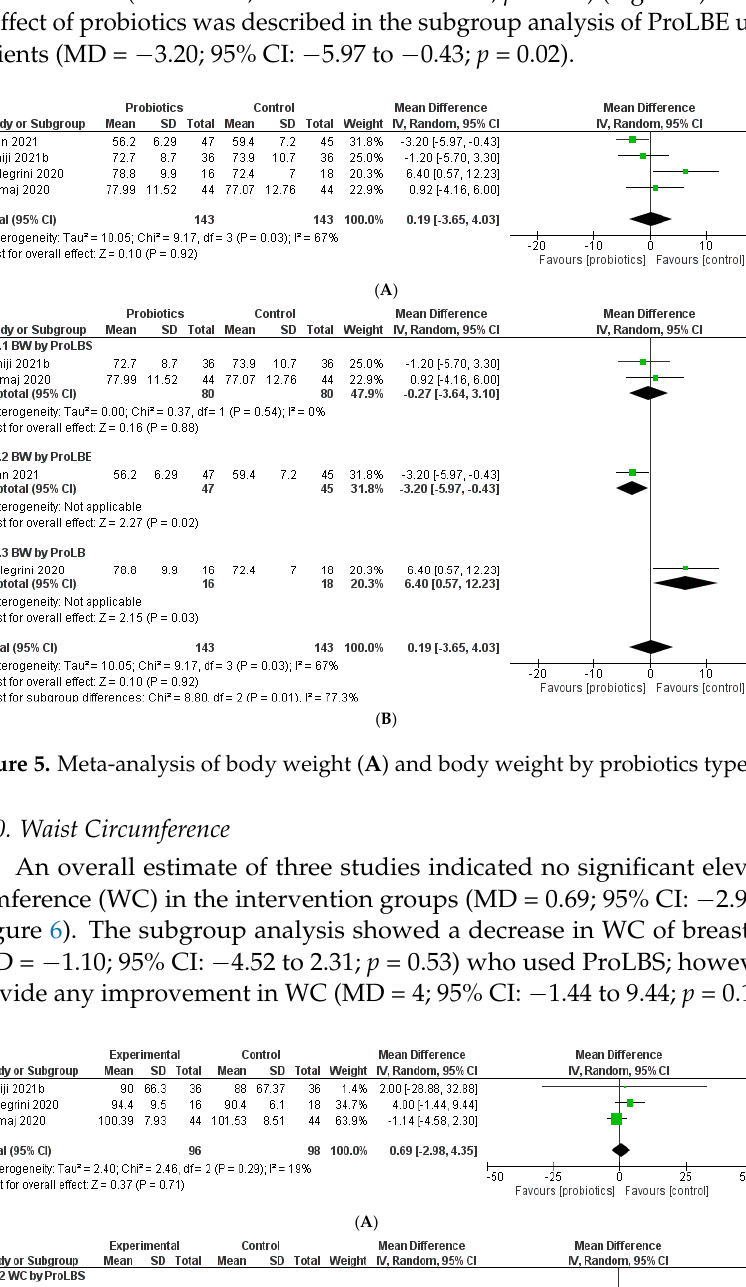
Figure 7. Meta-analysis for tumor necrosis factor-alpha (TNF- α ). 3.12. High-Sensitivity C-Reactive Protein Analysis of two studies including hs-CRP data in breast cancer survivors indicated that intervention with ProLBS plus FOS did not cause any overall alterations to hs-CRP levels detected (MD = 0.5; 95% CI: −0.97 to 1.96; p = 0.51). Furthermore, the between-study heterogeneity was significantly high ( I 2 = 82%, p = 0.02); see Figure 8.